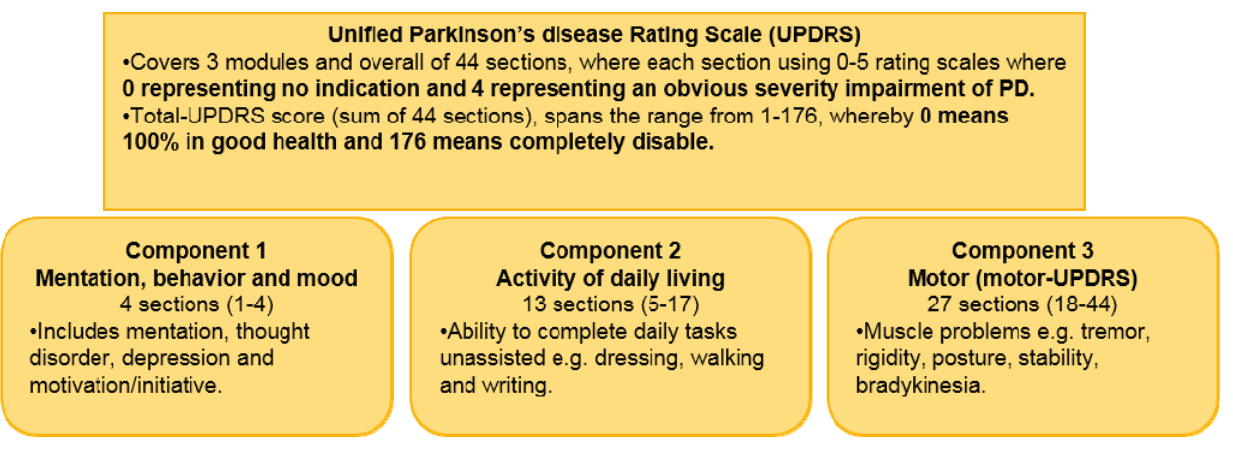
Figure 3. Overview of the clinical metric-Unified Parkinson Disease Rating Scale UPDRS (adapted from